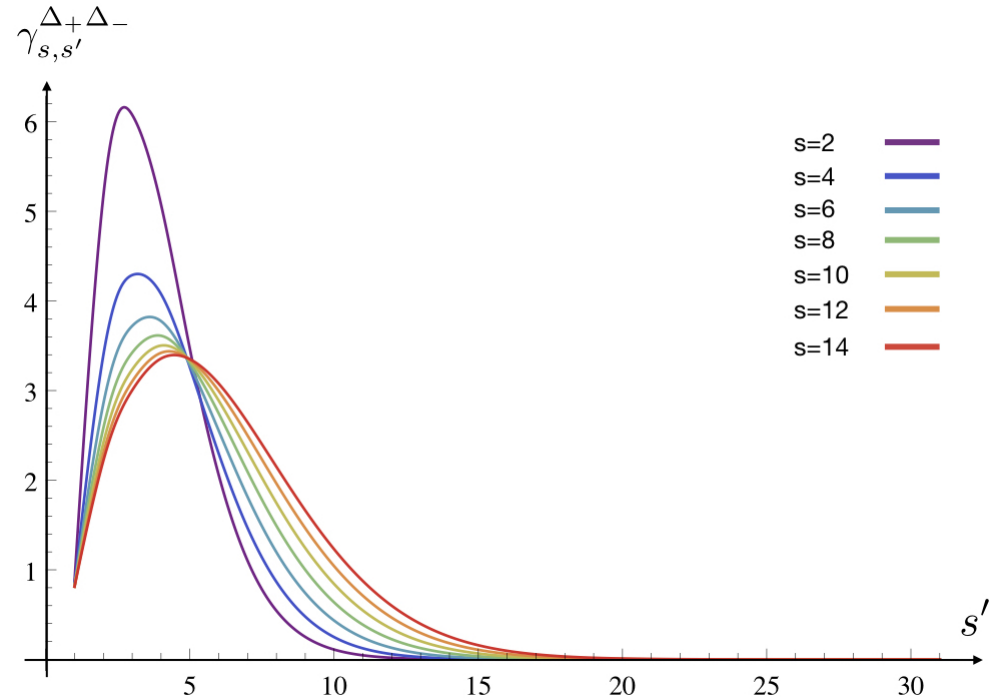
Figure 10. Plot of the contributions to the anomalous dimension from a single cut of the s (cid:0) ( s 0 0) (cid:0) s bubble diagram on the internal scalar leg. On the horizontal axis we vary the internal spin s 0 , while the colour gradient represents varying external spin s . The contributions are exponentially suppressed for large s 0